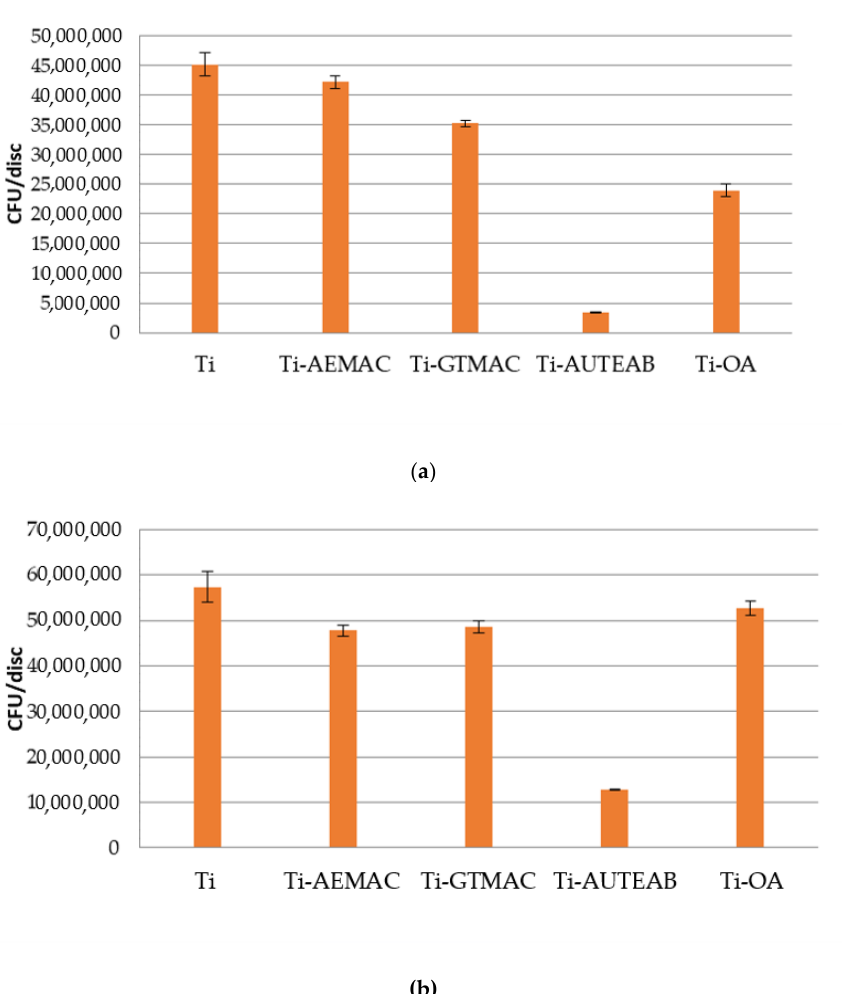
Figure 12. ( a ) Number of E. coli ( a ) and of ( b ) S. aureus adhered after 24 h of bacterial contact on bare titanium discs (Ti) and on the functionalized samples Ti-AEMAC, Ti GTMAC, Ti-AUTEAB, and Ti-OA P; Error bars indicate standard deviation (SD) from three independent CFU counting (i.e., n = 6). “Elaboration standard deviation with ANOVA, p < 0.0001 ” .